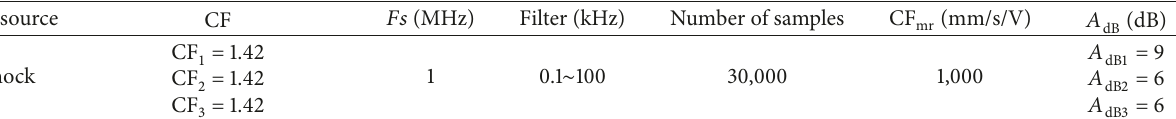
Table 2: Measurement condition of point explosive induced pyroshock on the disk type specimen.